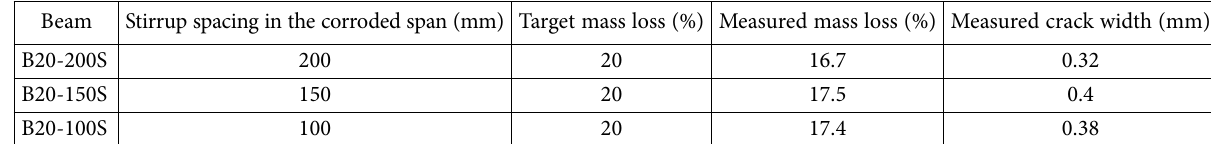
Figure 1. Reinforcement details and dimensions Table 1. Test beams and corrosion damage